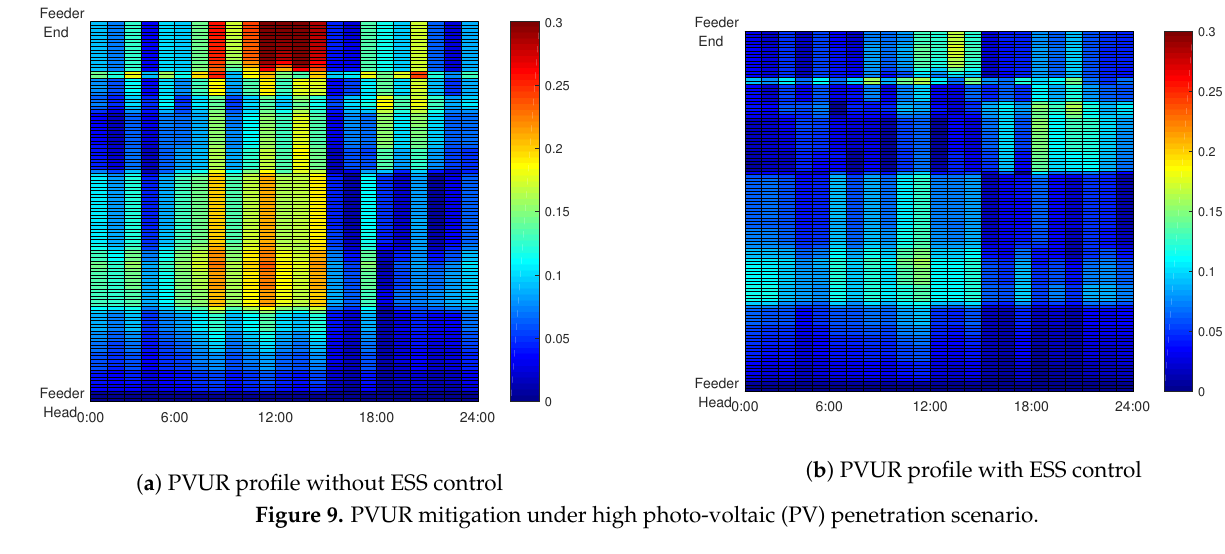
Figure 9. PVUR mitigation under high photo-voltaic (PV) penetration scenario.